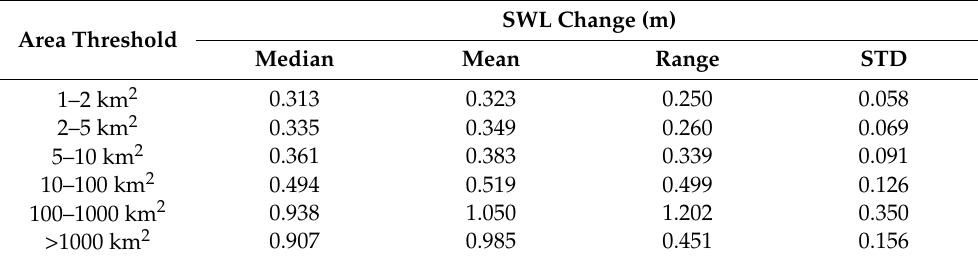
Table 3. SWL numerical statistics grouped by lake